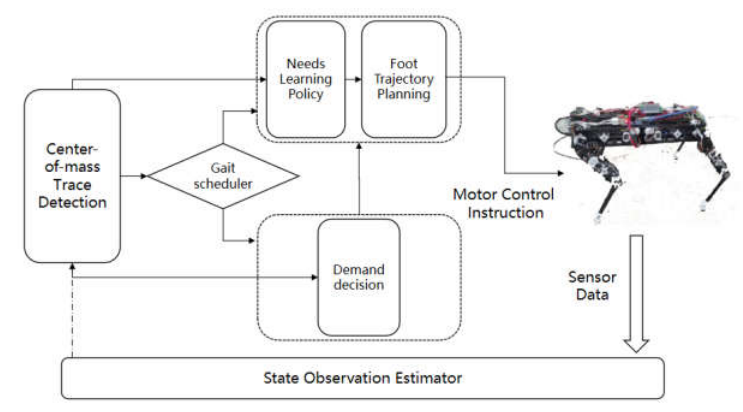
Figure 9. Control block diagram of the quadruped robot control policy.